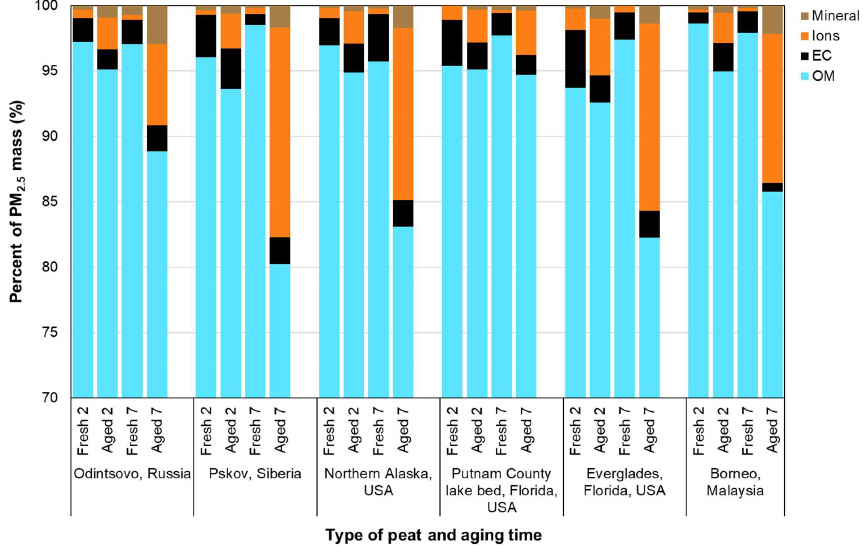
Figure 6. Reconstruction of PM 2 . 5 mass with organic mass (OM, see Table 3 for OM / OC ratios), elemental carbon (EC), major ions (i.e., sum of NH + , NO − , and SO = ), and mineral component ( = 2.2Al + 2.49Si + 1.63Ca + 1.94Ti + 2.42Fe) for six types of peat between fresh 4 3 4 and aged